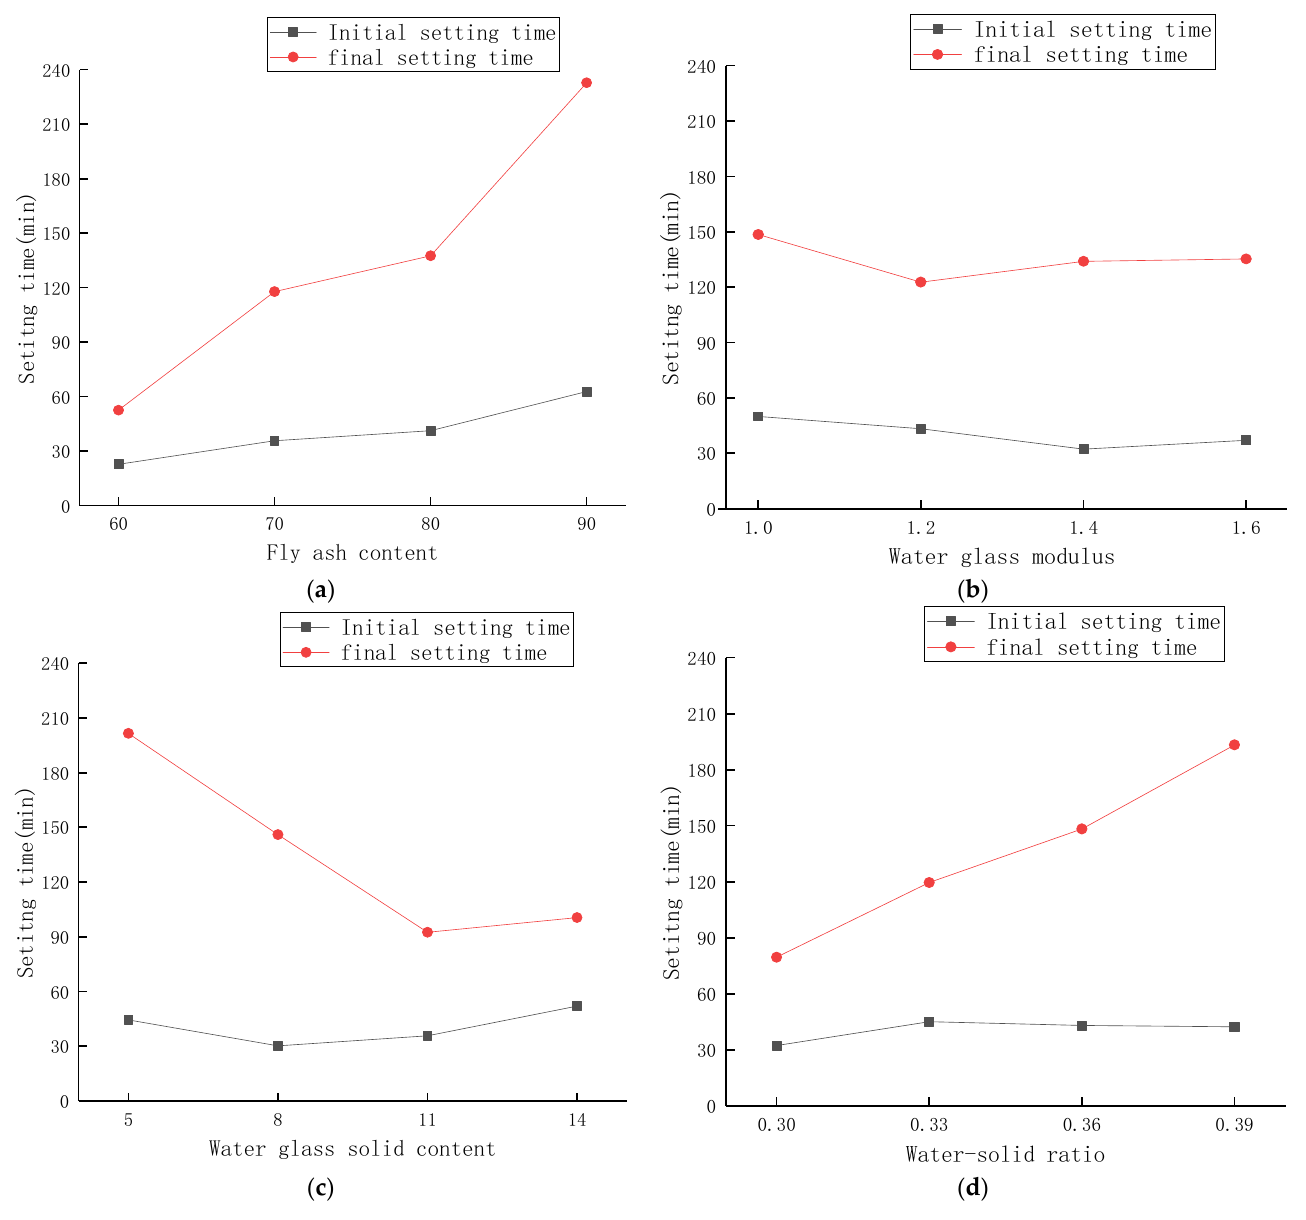
Figure 3. Influence of parameters on setting time of composite gelling system. ( a ) Influence of fly ash content on setting time. ( b ) Influence of water glass modulus on setting time. ( c ) Influence of water glass solid content on setting time. ( d ) Influence of water–solid ratio on setting time.